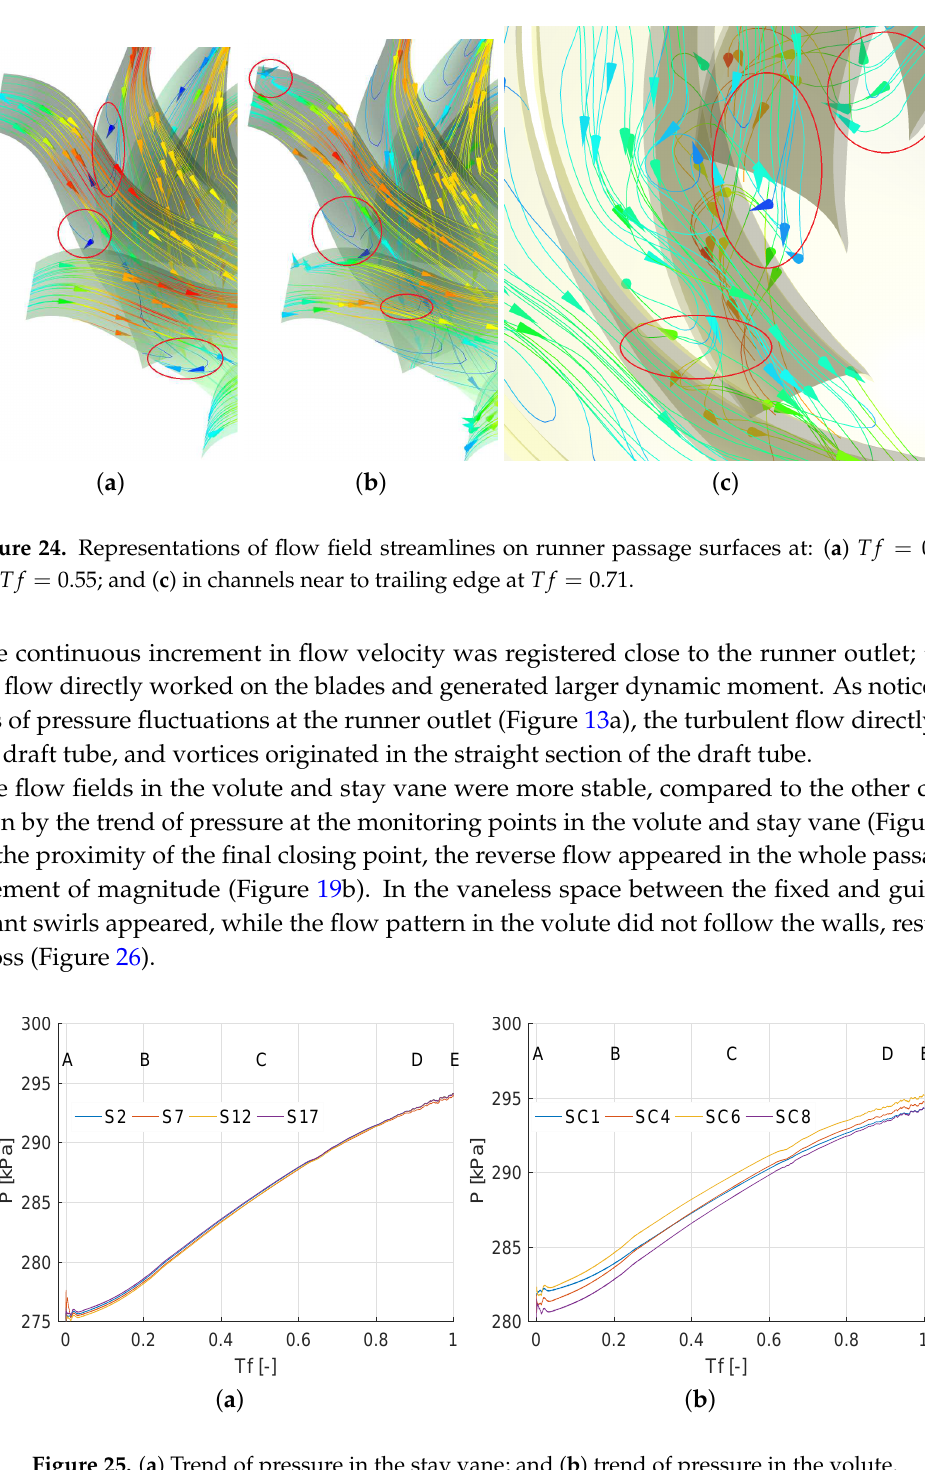
Figure 25. ( a ) Trend of pressure in the stay vane; and ( b ) trend of pressure in the